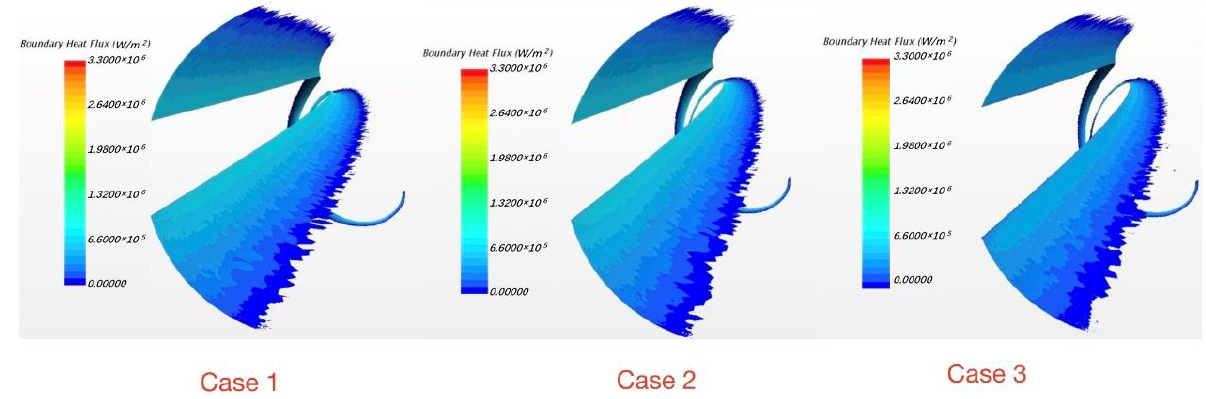
Figure 21. The reversed heat flux varies with calculation domain.